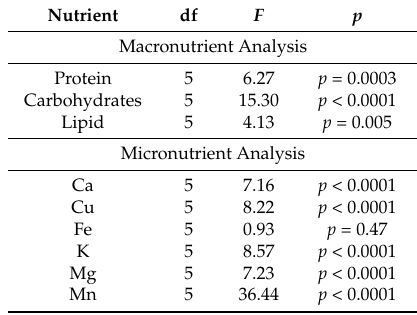
Table 2. Results for each nutrient from the MANOVAs for macro- and micronutrients for adult Trypoxylon lactitarse.